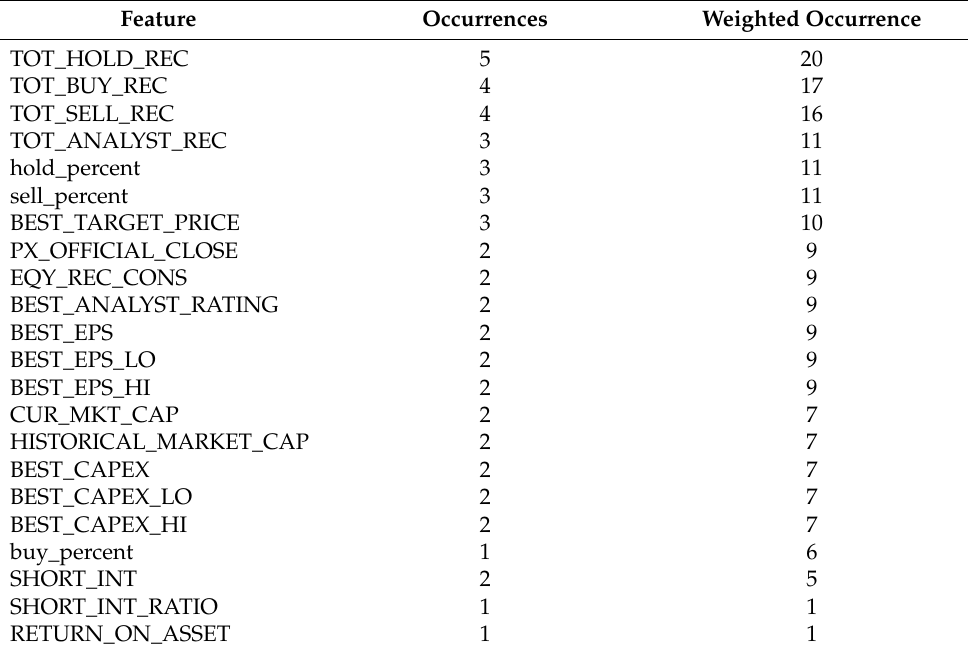
Table 6. The occurrence of each feature in the first 6 PCA components.